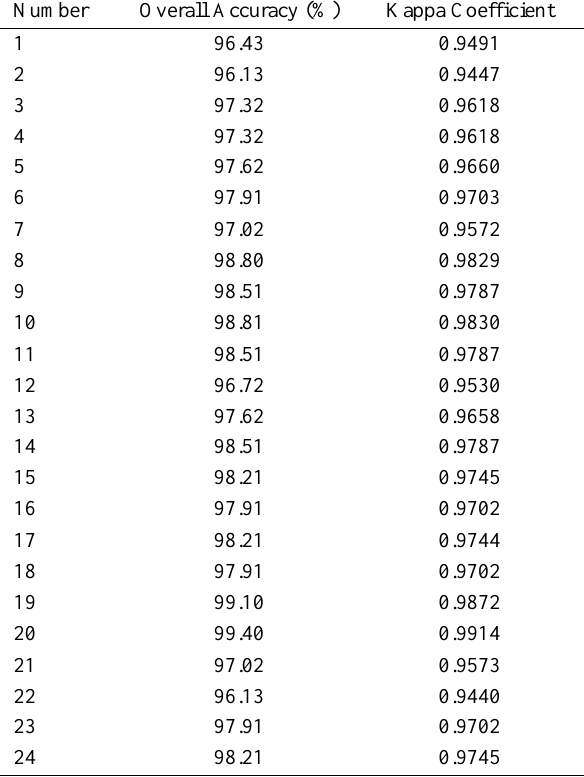
Table 4 . Accuracy of maps classified by random forest